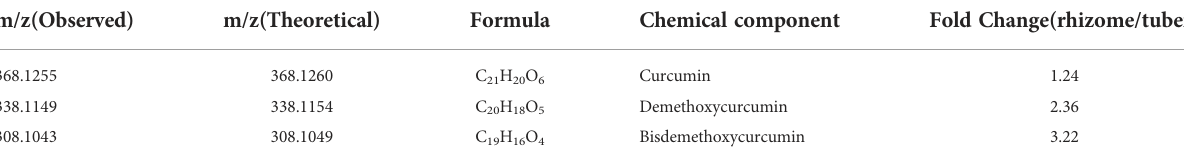
TABLE 2 The m/z value and fold change of curcuminoid in turmeric different tissues (tubers and rhizomes).